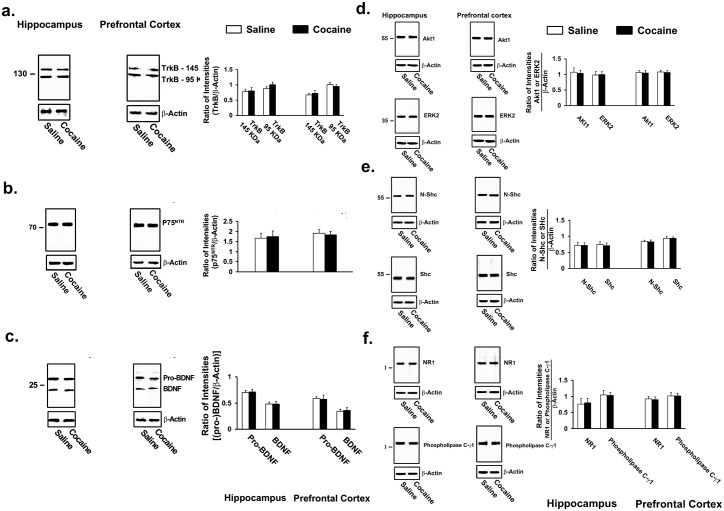
Prenatal cocaine exposure did not alter the expression levels of full-length (145-KDa) and truncated (95-KDa) TrkB, p75NTR, pro-BDNF and BDNF, Akt1 and ERK2, N-Shc and Shc, as well as NR1 and PLC-γ1 in both hippocampus and prefrontal cortex.The expression levels of 145- and 95-KDa TrkB (a). P75NTR (b), pro-BDNF and BDNF (c) as well as Akt1 and ERK2(d), Shc and N-Shc (e), NR1 and PLC-γ1(f), in 50 μg post-mitochondrial synaptosome-enriched fractions prepared from hippocampi and PFCX of P21 rats exposed to saline or cocaine in utero were compared by Western blotting. The blots were stripped and re-probed with anti-β-actin to validate equal loading. Densitometric quantification of blots revealed no discernible differences in 145- and 95-KDa TrkB, P75NTR, proBDNF and BDNF, Akt1, ERK2, Shc and N-Shc, NR1 and PLC-γ1 expression levels. n = 4. Data are mean ± s.e.m. of the ratio of 145-, 95-KDa TrkB, p75NTR, proBDNF, BDNF, Akt1, ERK2, N-Shc, Shc, NR1 or PLC-γ1to β-actins optical intensities.